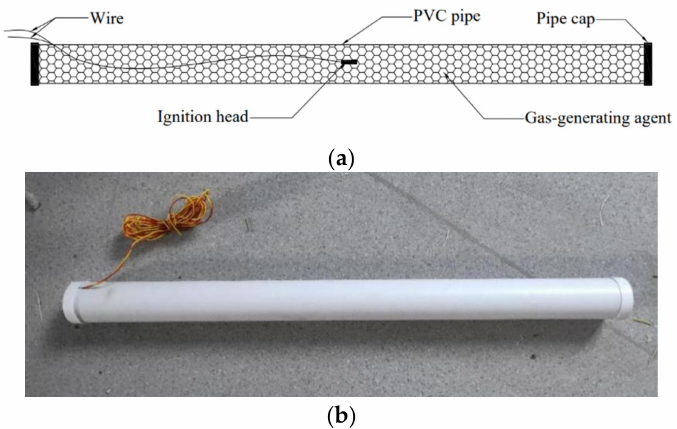
Figure 1. Structure schematic drawing and product picture of expansion pipe. ( a ) Structure schematic drawing; ( b ) Product